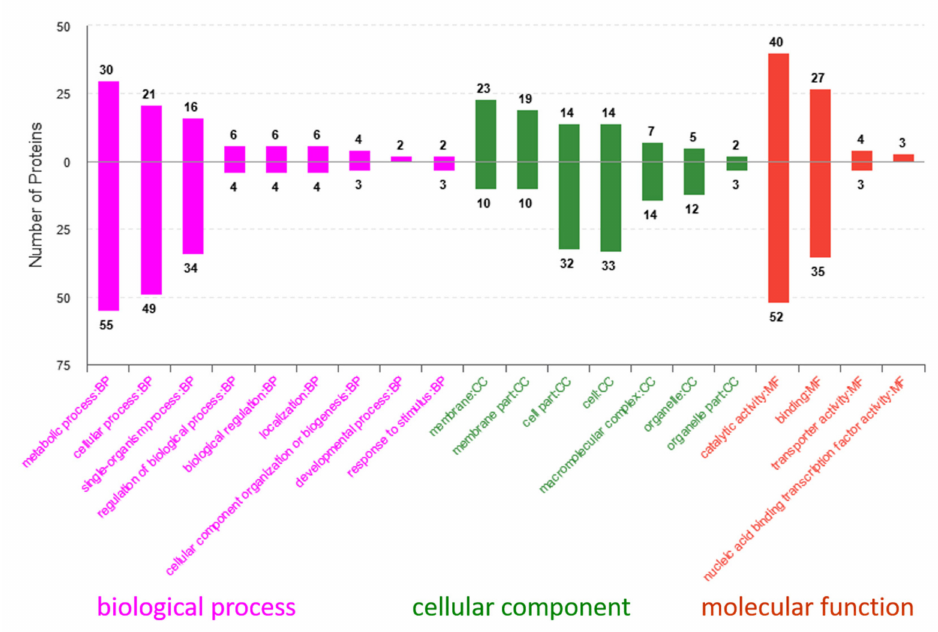
Figure 5. Gene ontology annotation of distribution analysis: The upward column represents the upregulated protein amount in the treatment group, and the downward column represents the downregulated protein amount in the treatment group. BB: biological process; CC: cellular component; MF: molecular function.